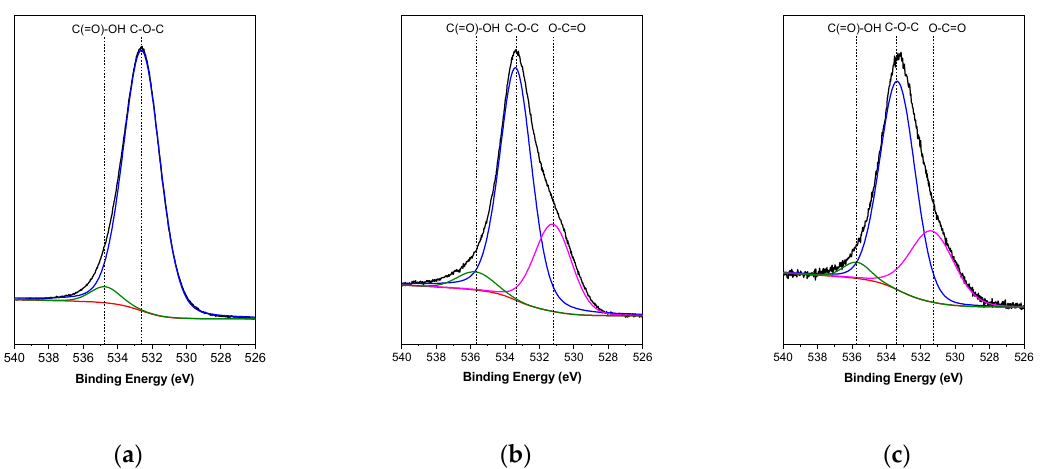
Figure 4. Contributions of functional groups of C1s photoelectric lines obtained from X-ray photoelectron spectroscopy (XPS) for GO ( a ), TRGO 600 ( b ), and TRGO 1000 ( c ).